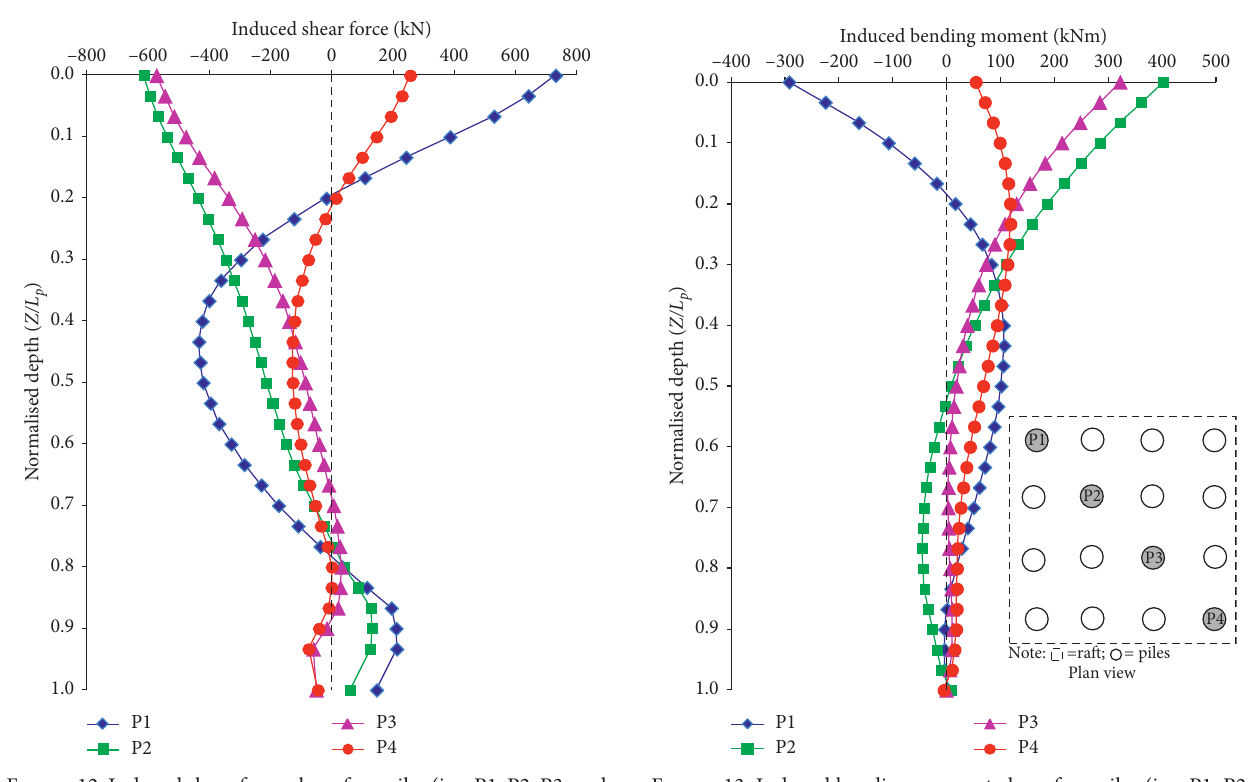
Figure 12: Induced shear force along four piles (i.e., P1, P2, P3, and P4).